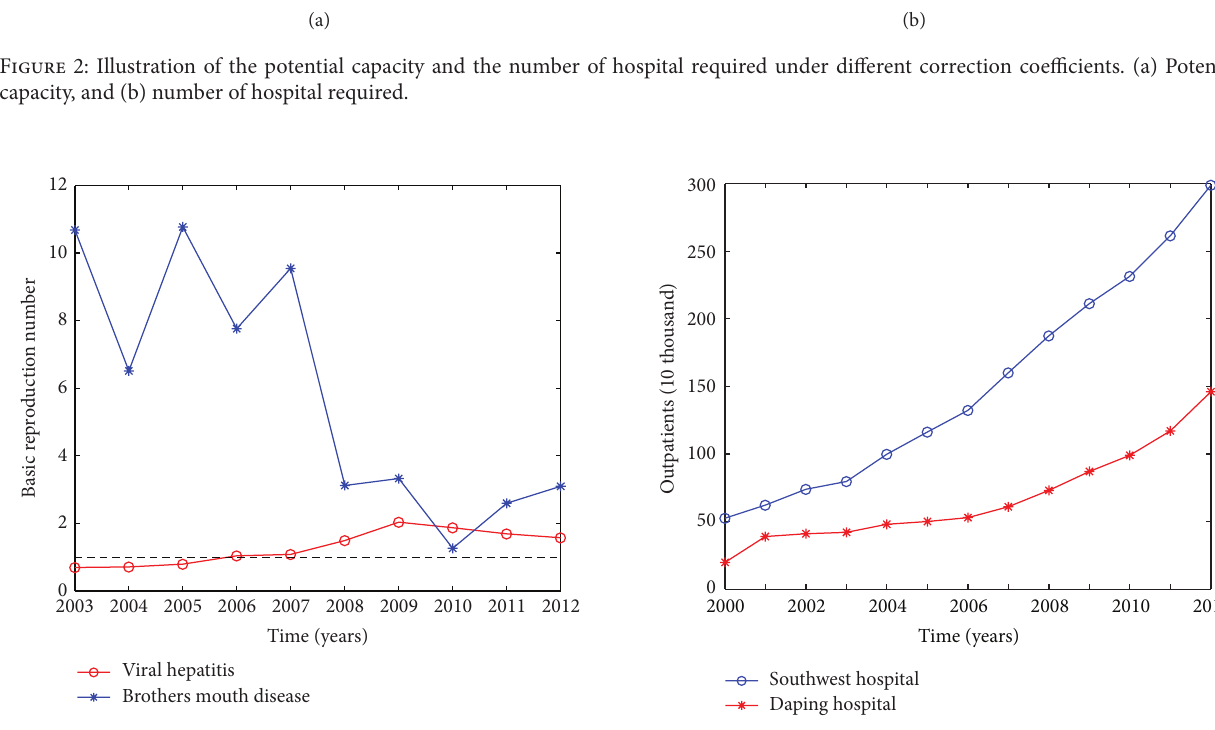
Figure 4: Comparison of outpatients in Chongqing Southwest Hospital and Chongqing Daping